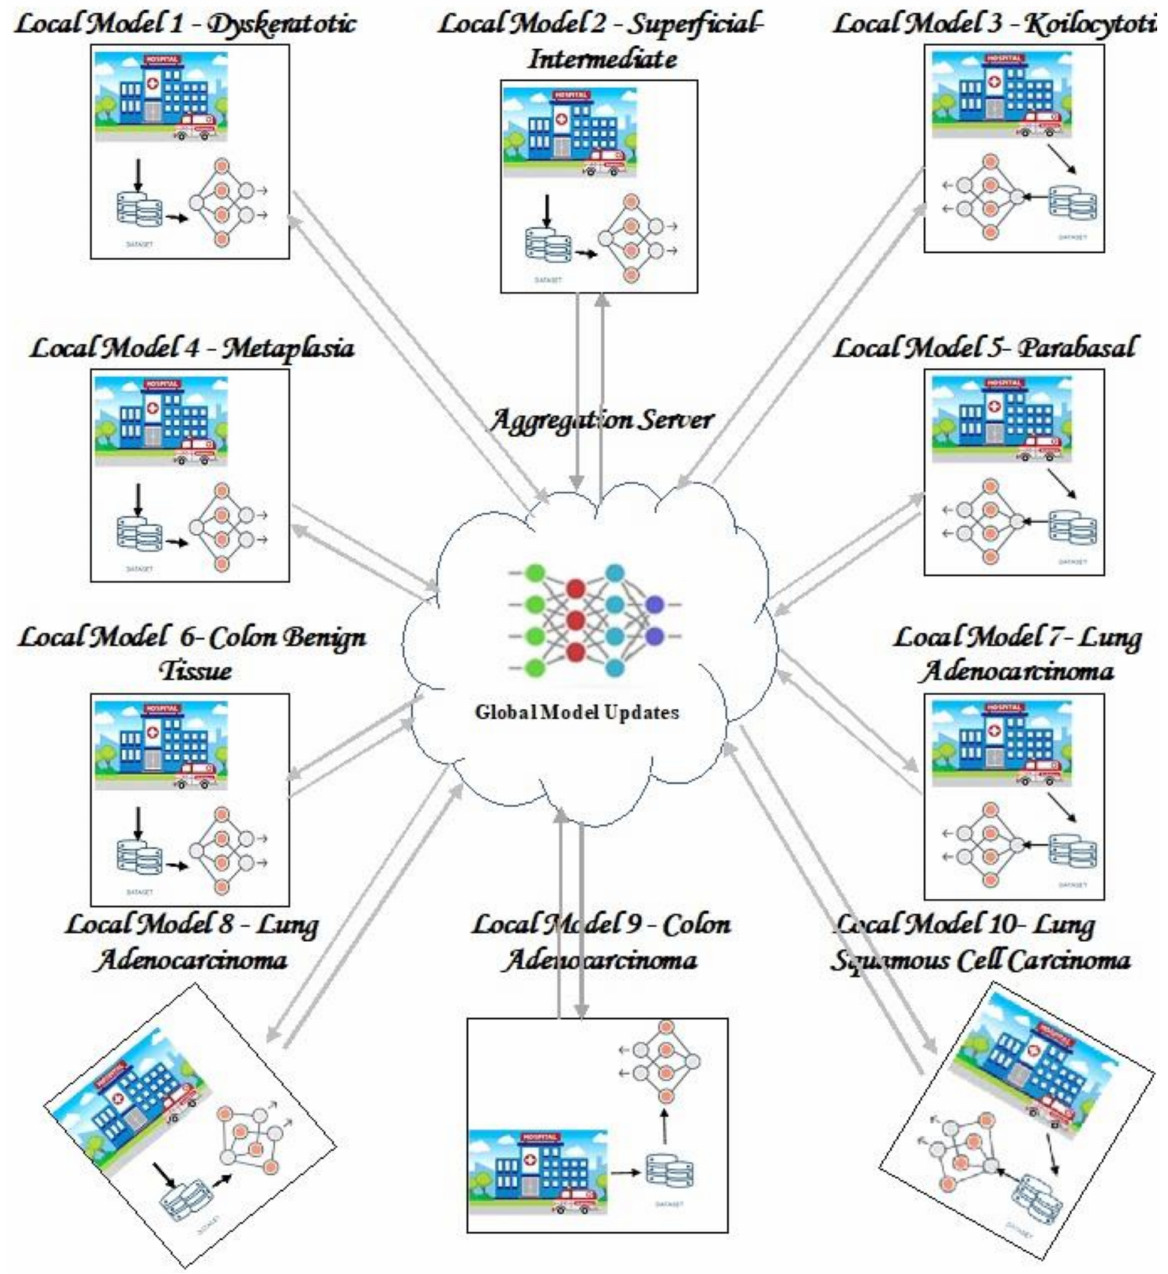
Figure 1. Proposed FL